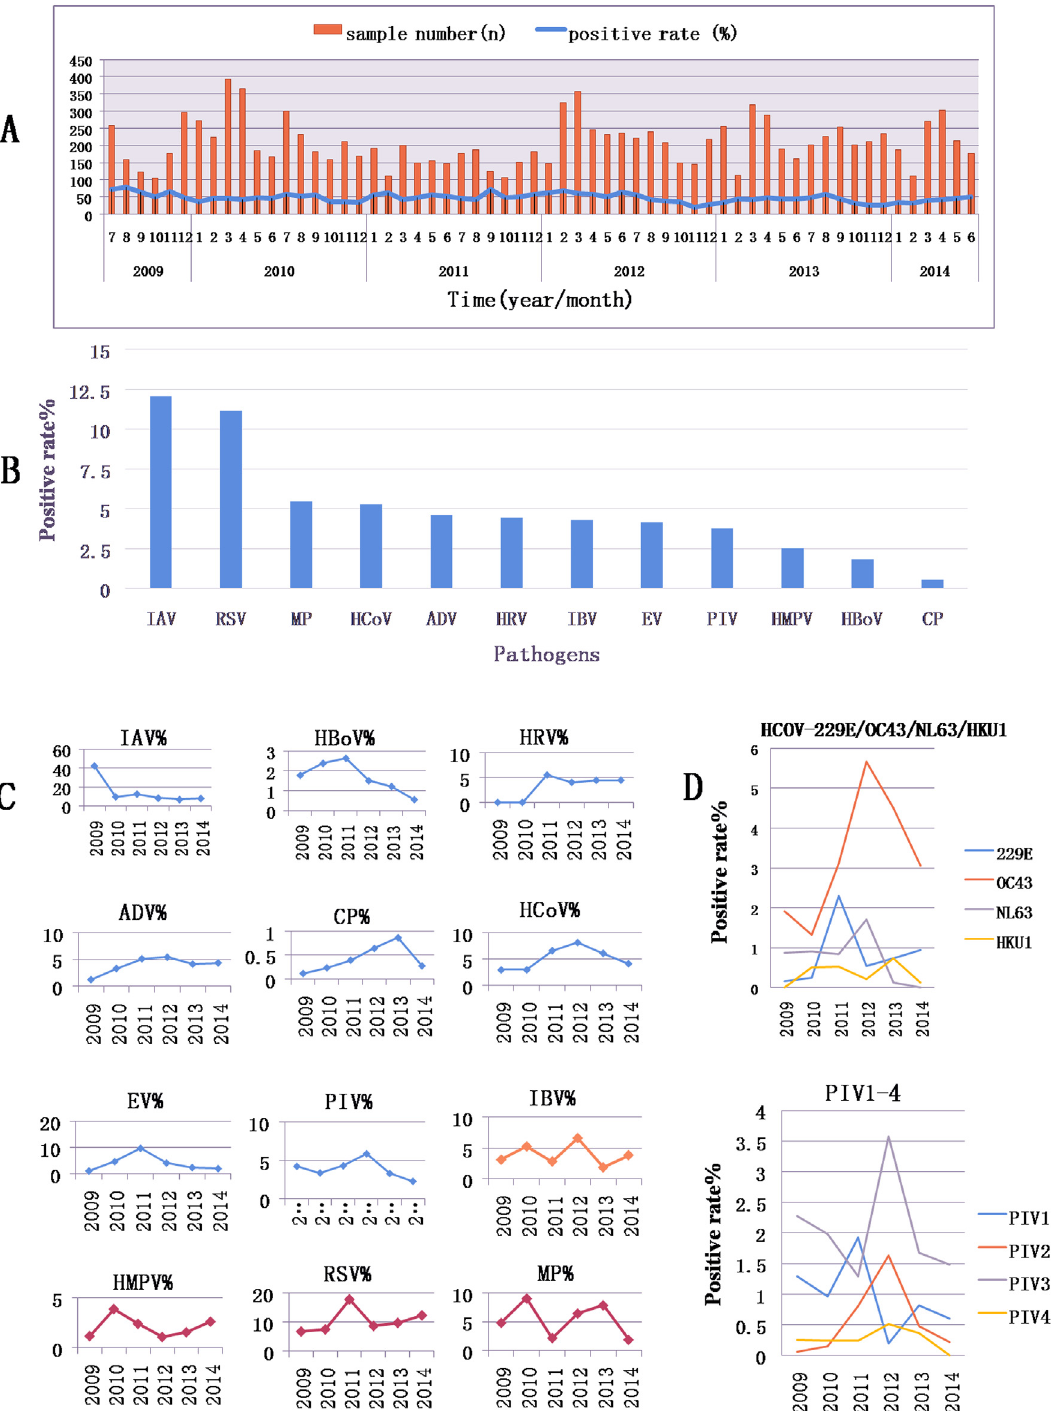
Fig 2. Pathogens ’ prevalence over 5 years. A, the total number of samples and the PDR patterns in each month of each year; B, the prevalence patterns of different pathogens over five years; C , prevalence peaks over 5 years: one peak (lines in blue), two peaks (lines in red), and three peaks (lines in orange), (%):typical indicates the positive rate of pathogens; D, the yearly prevalence patterns of the 4 types of HCoV and 4 types of PIV.